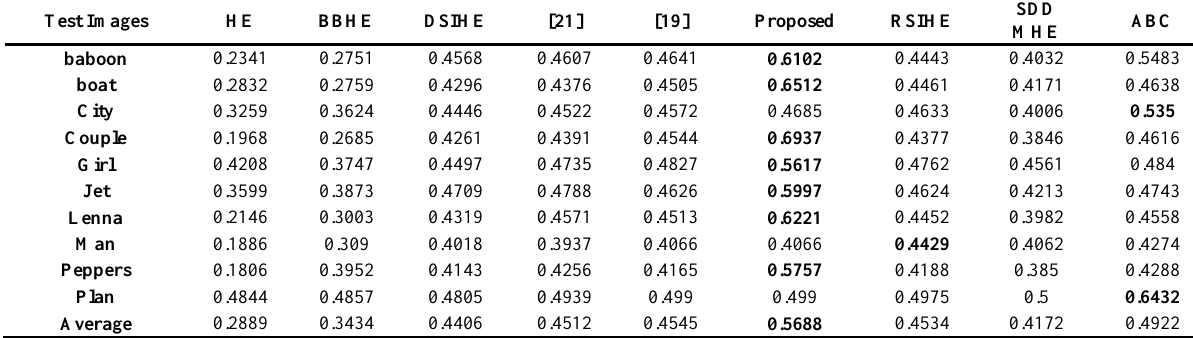
Table 4. Comparing various methods with